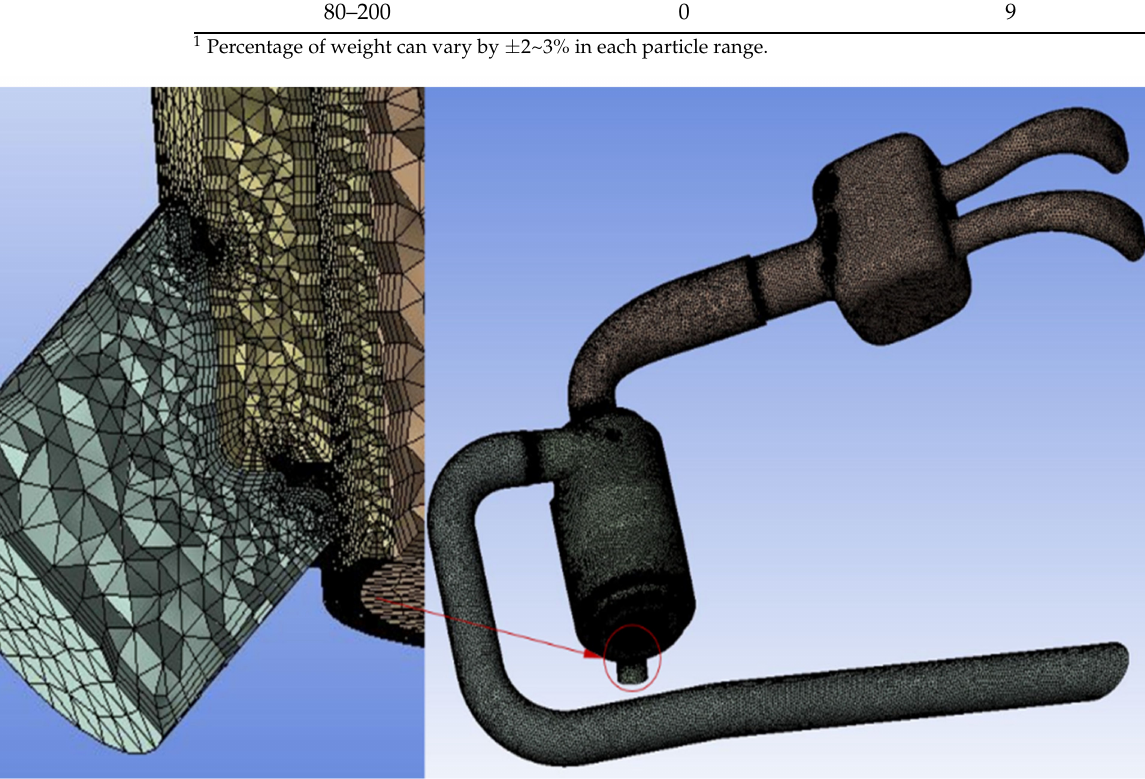
Figure 5. Computational mesh of the intake system with four-layer